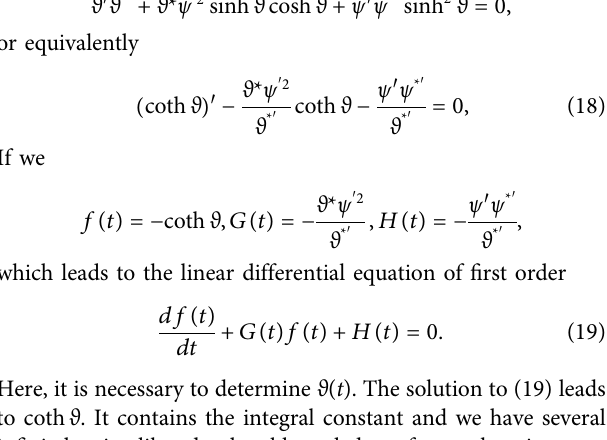
FIGURE 7 | Timelike developable with c (cid:3) −